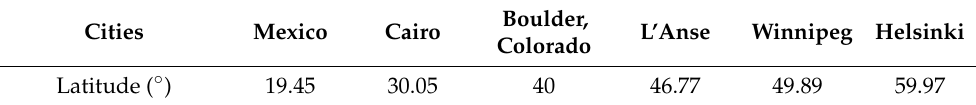
Table 8. Cities and corresponding latitudes that were considered for the location sensitivity analysis.